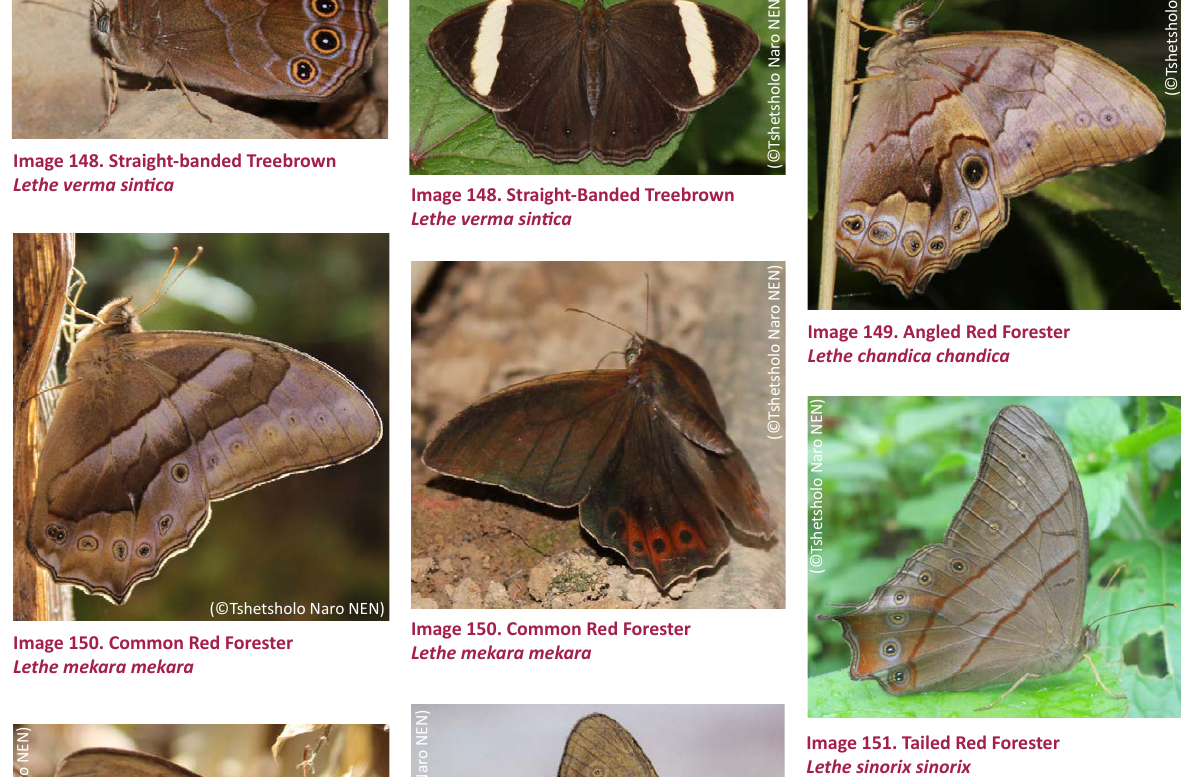
Image 151. Tailed Red Forester Lethe sinorix sinorix